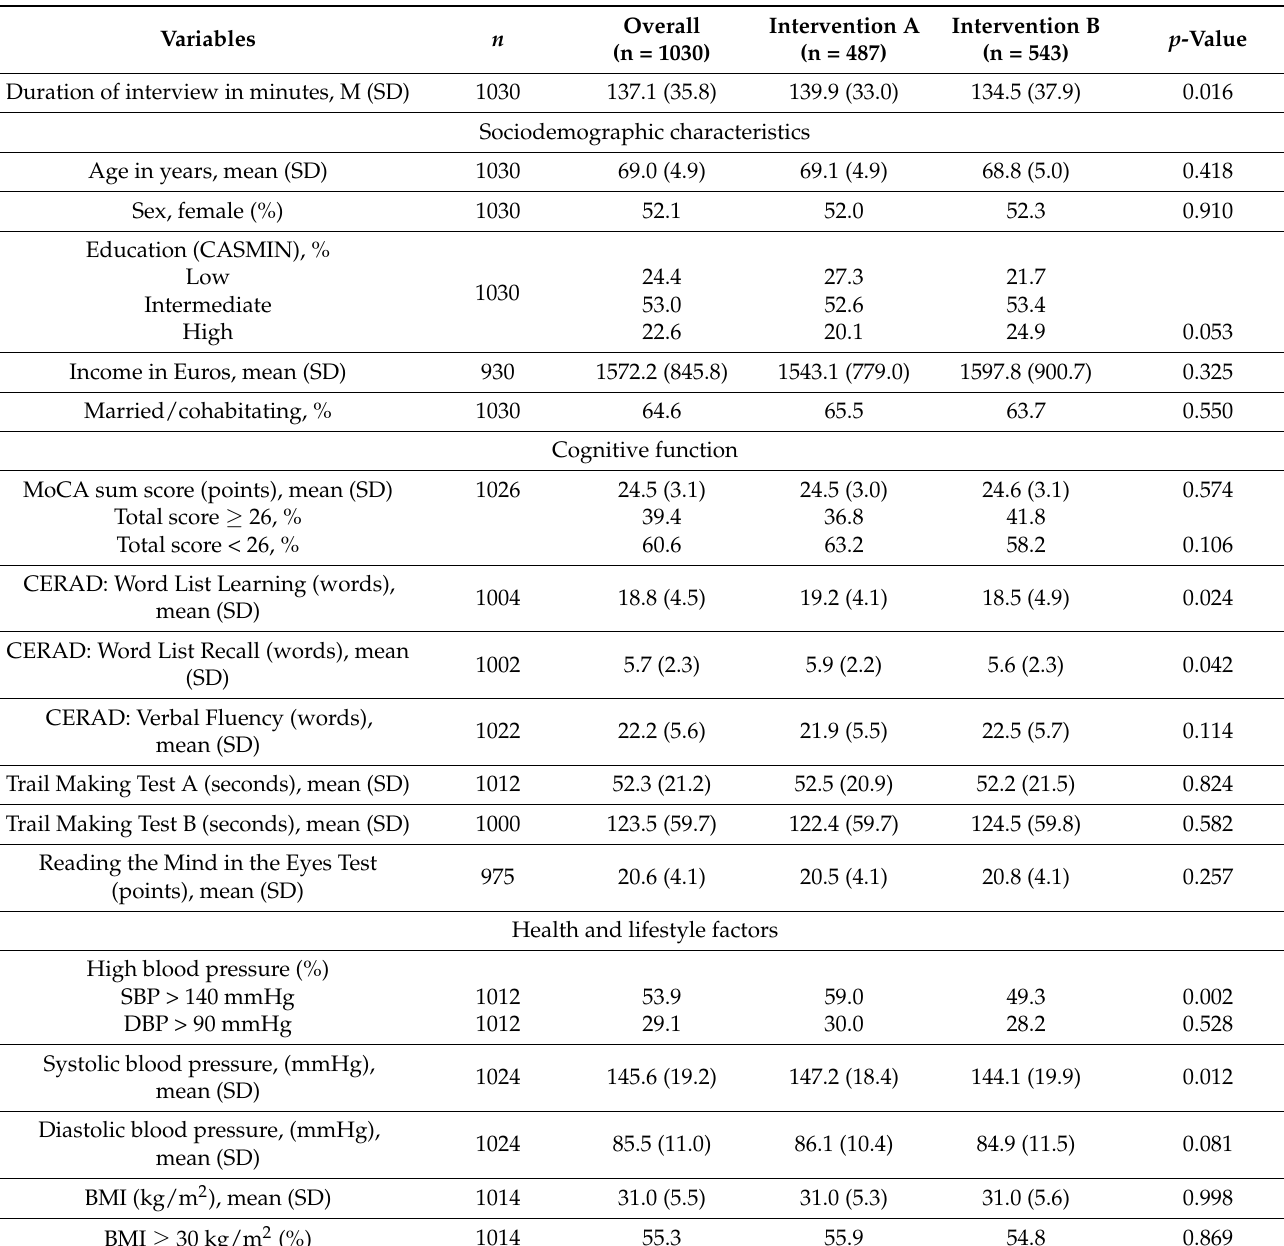
Table 3. Baseline characteristics of study participants in the AgeWell.de trial with respect to group allocation ( n = 1030). Variables n